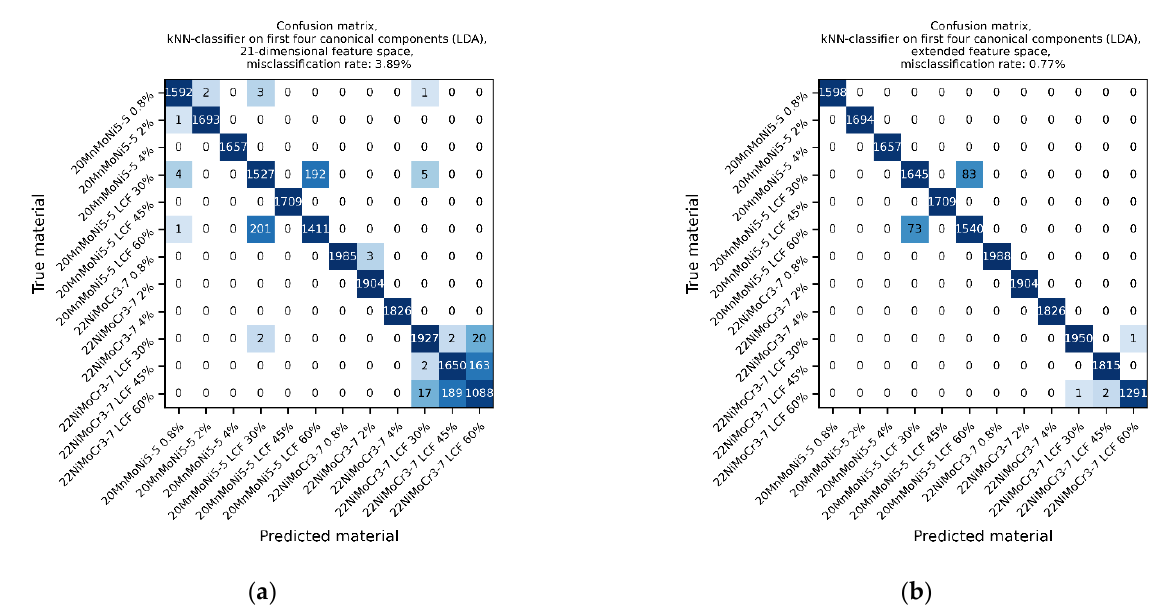
Figure 12. Confusion matrices of kNN-classification based on LDA transformation: ( a ) 21-dimensional feature space and ( b ) extended feature space.